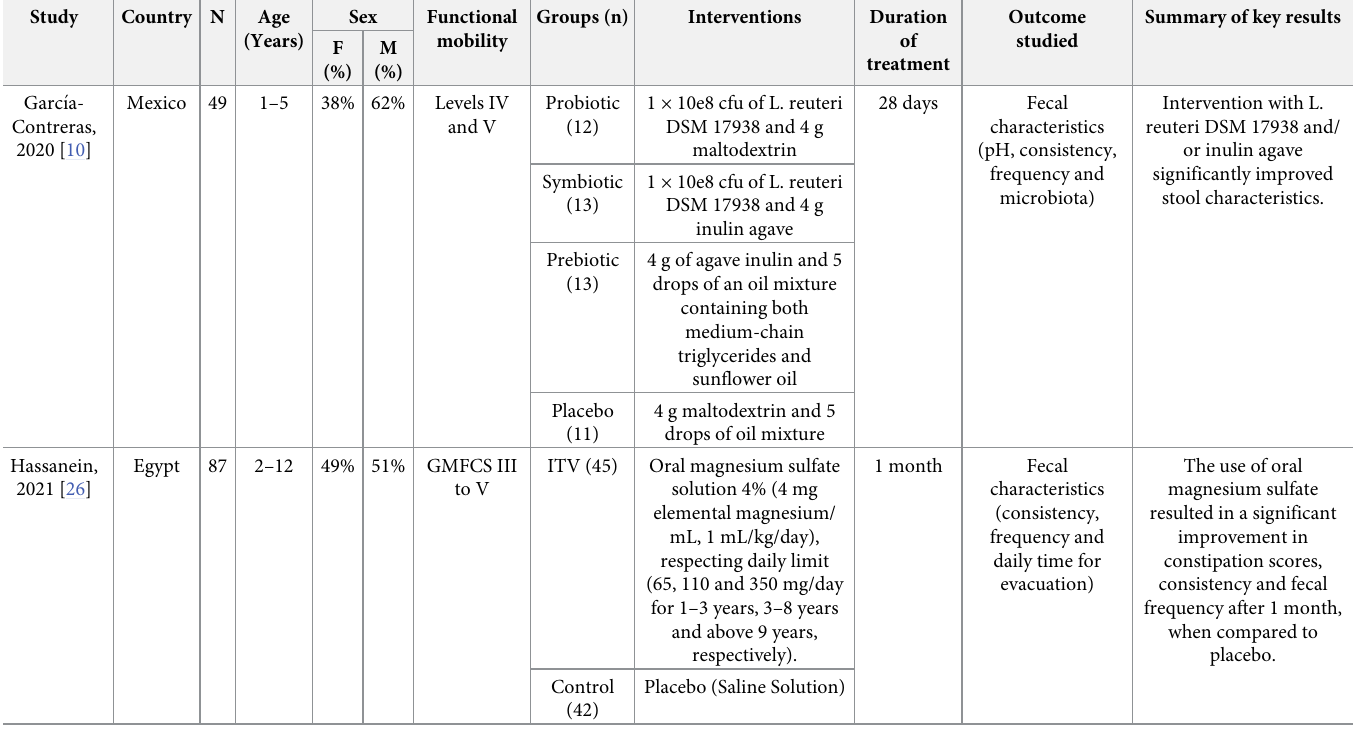
Table 4. Characteristics of the studies evaluating as main outcome constipation and fecal